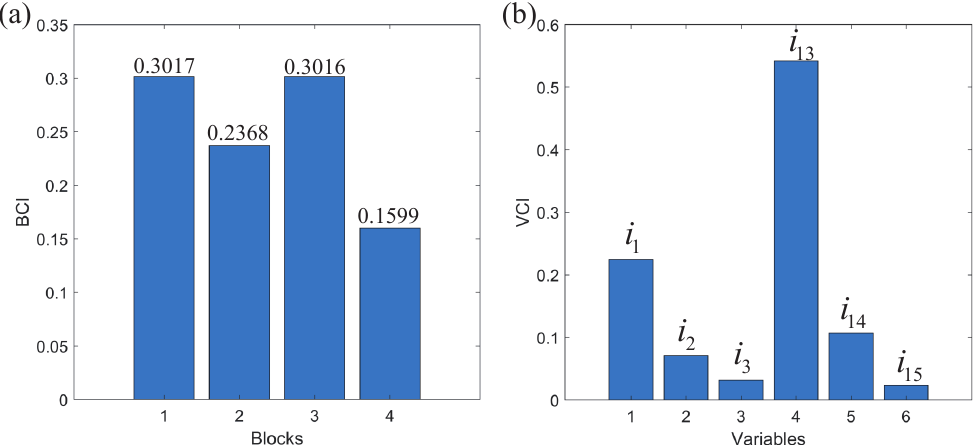
Figure 15. The anomaly isolation results of anode effect in aluminum electrolysis process. ( a ) BCI; ( b ) VCI-Block